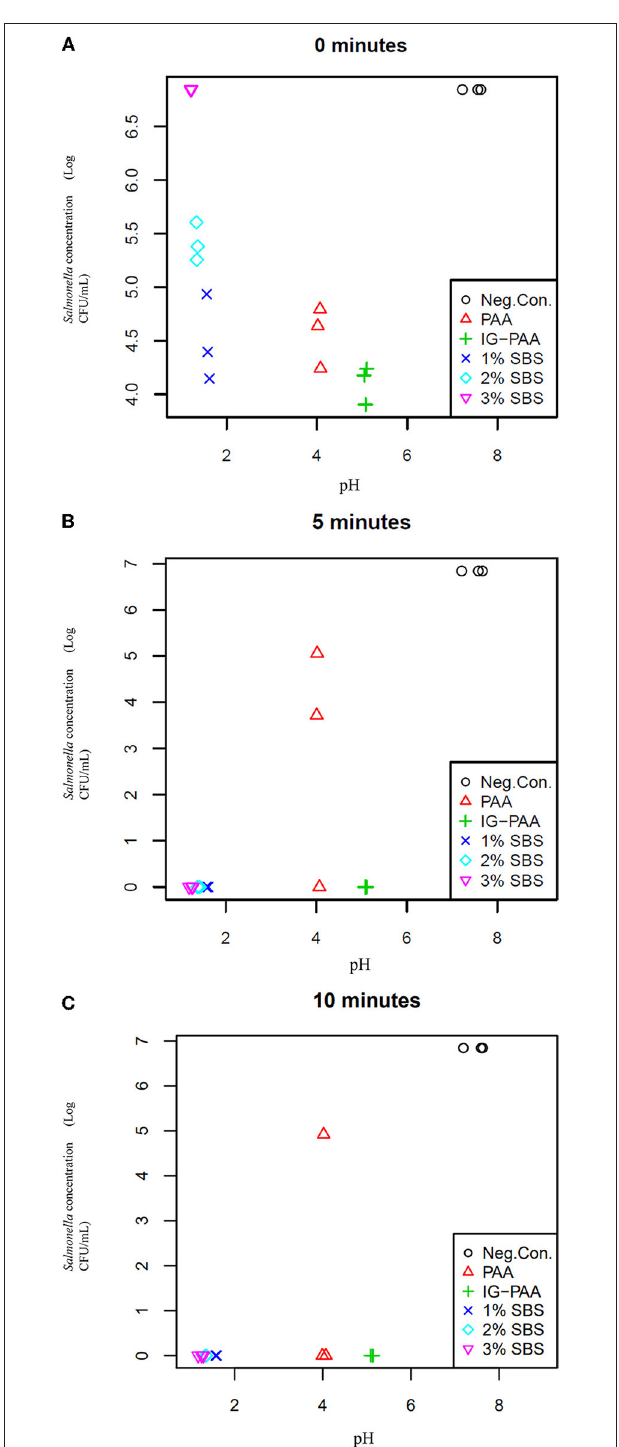
FIGURE 3 | Comparison of pH and Salmonella Typhimurium concentration at 0, 5, and 10min. (A) Represents comparisons of pH and S. Typhimurium concentration at time point 0min. The pH was adjusted using the acidifier treatments. The inoculum added initially was 3 × 10 7 CFU/mL S. Typhimurium UK-1 to each microcosm ( n = 3). Plots (B,C) represent the comparison of pH and Salmonella concentration at 5 and 10min and were generated in the same manner as (A)